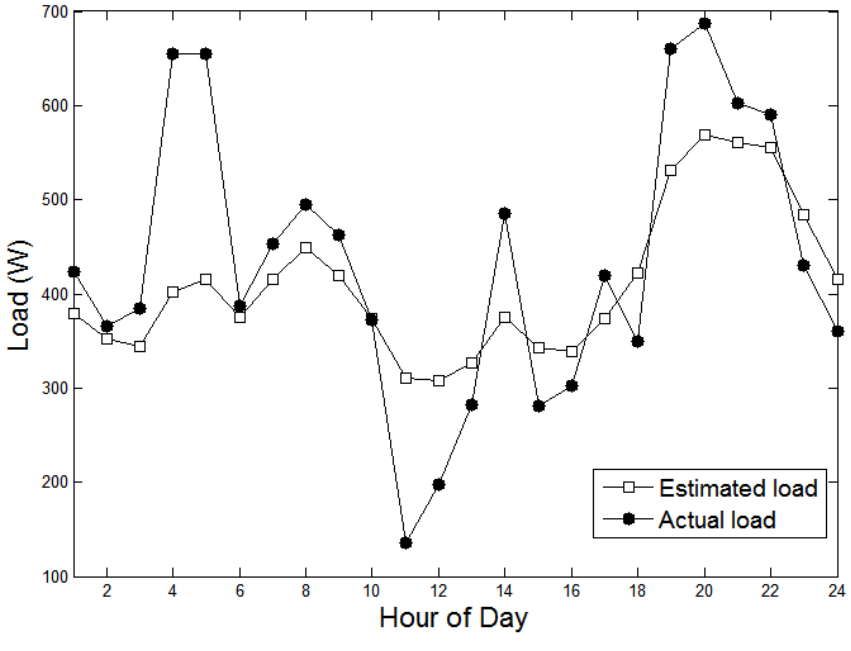
Figure 18. Use of PV power, battery charge status and electrical cost under Scenario